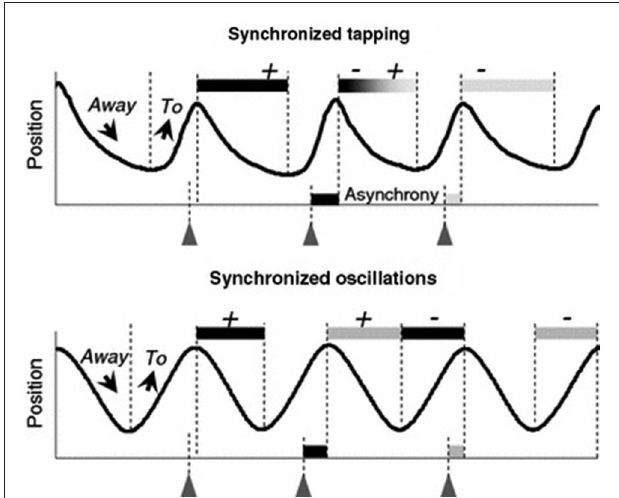
FIGURE 1 | Correlation patterns between the asynchronies and the two preceding and two following phases To and Away observed in synchronized tapping and oscillation tasks . The + and − signs represent the positive or negative correlations between the phases and the related asynchrony. During discrete tapping the duration of a given Away phase is related to both the preceding and the succeeding asynchronies. During smooth finger oscillations, two consecutive asynchronies do not happen to be correlated with the same semi-cycle (reproduced with permission from Torre and Balasubramaniam,